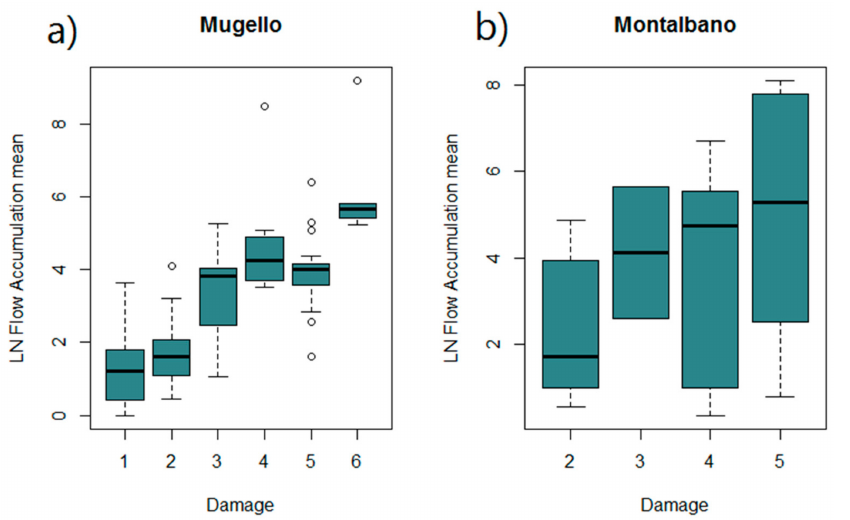
Figure 7. Box plot of the relationship between the subjective damage class and the flow accumulation values (logarithmic scale)—Boxplot: Box = 1.5 × IQR, Q1, Q2, Q3; Whiskers = Min and Max. ( a ): Mugello case, ( b ): Montalbano